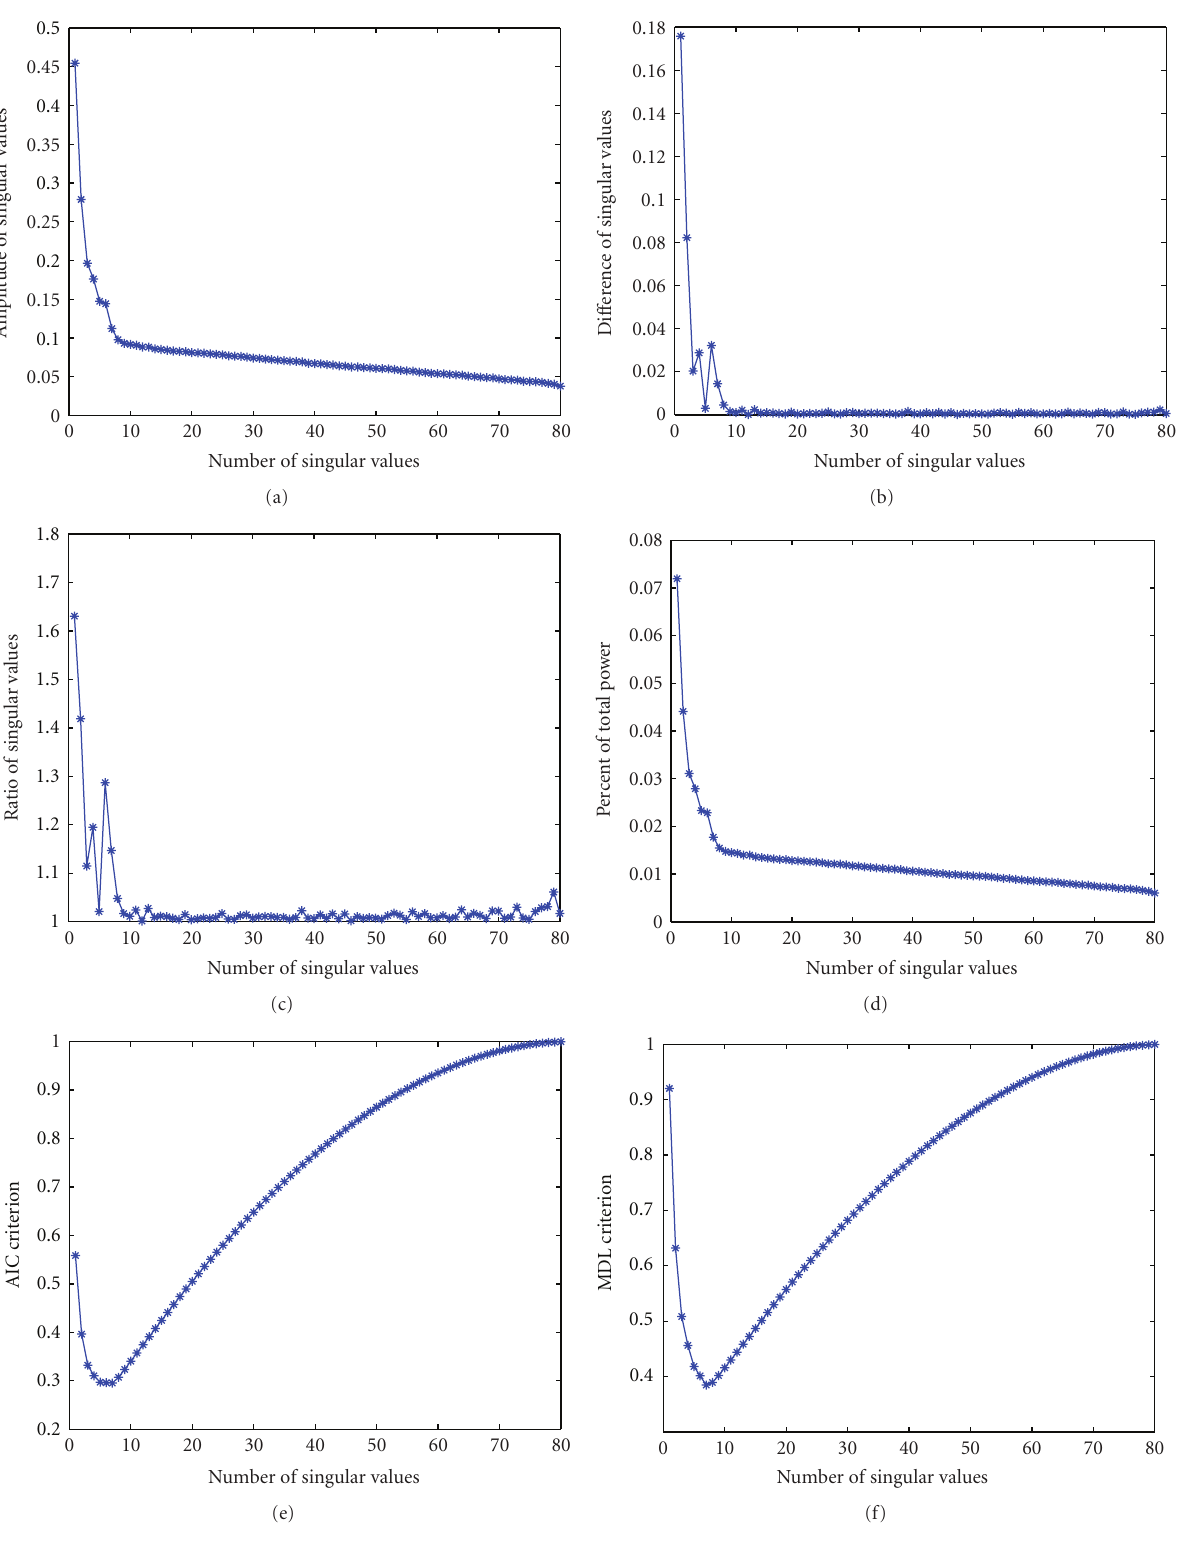
Figure 13: Example 3: Multiple (five) targets, (a) amplitude of singular values ( s m ), (b) di ff erence of singular values ( s m − s m +1 ), (c) ratio of singular values ( s m /s m +1 ), (d) power in singular values ( s m / tr[ X ]), (e) AIC function of singular values (10), and (f) MDL function of singular values